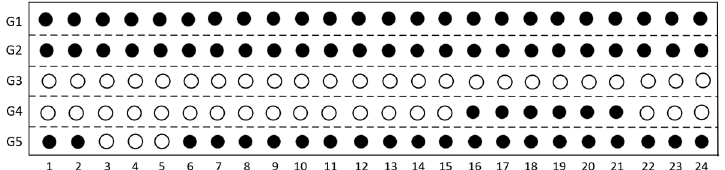
Figure 4. Wind power output and wind spillage in Case 1 and Case 2.